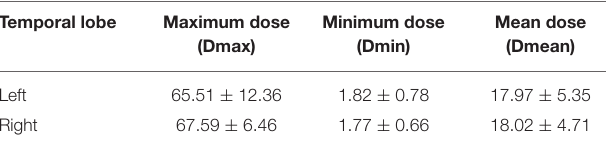
TABLE 1 | Dose–volume statistics of the bilateral temporal lobe for 33 patients with nasopharyngeal carcinoma treated with radiation therapy